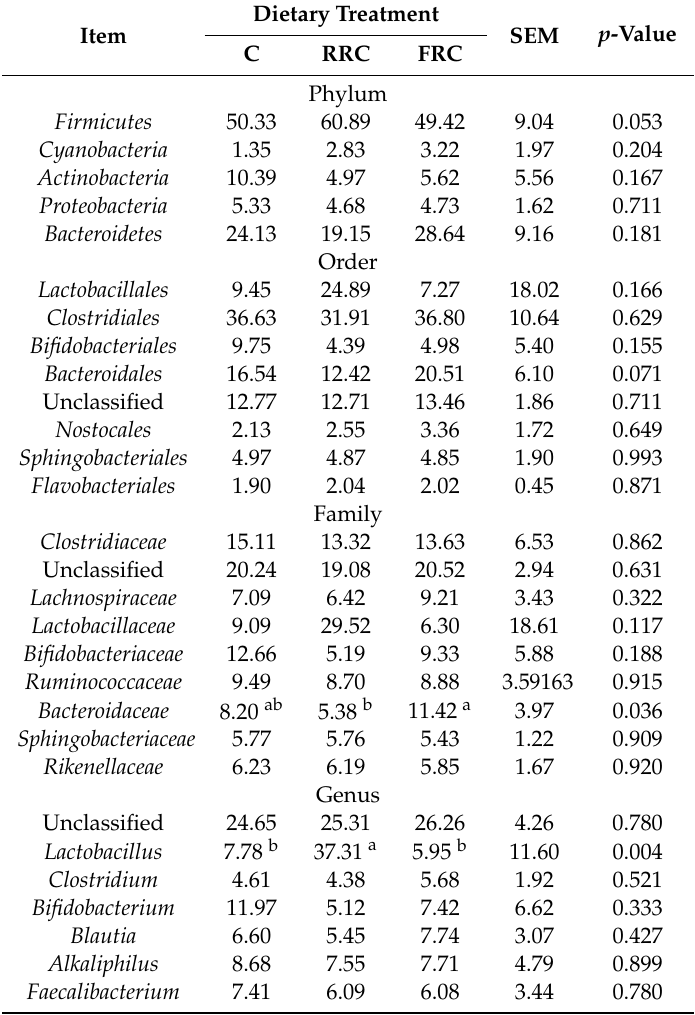
Table 5. Relative abundance of bacterial communities in the cecal digesta of turkeys fed a control diet (C) and diets containing raw rapeseed cake (RRC) or fermented rapeseed cake (FRC) 1